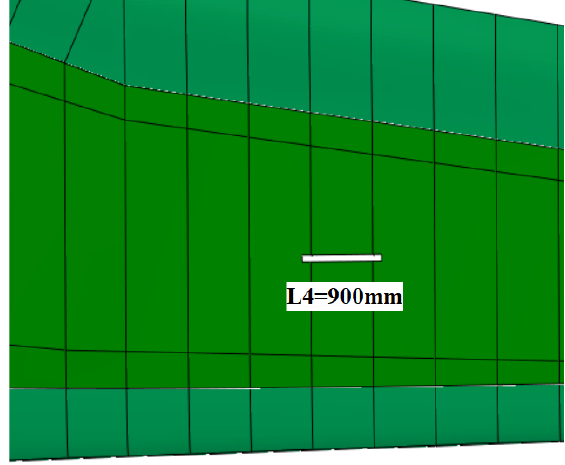
Figure 10. Illustration of the damage cutting through two rib components.